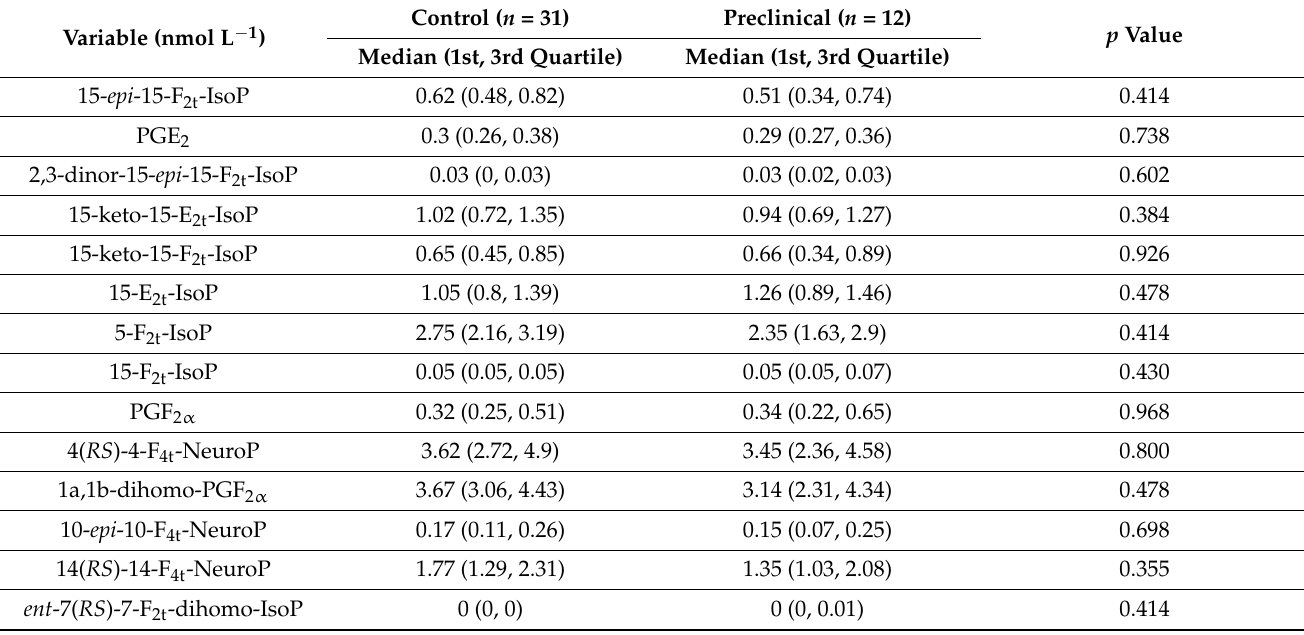
Table 3. Plasma levels of lipid peroxidation